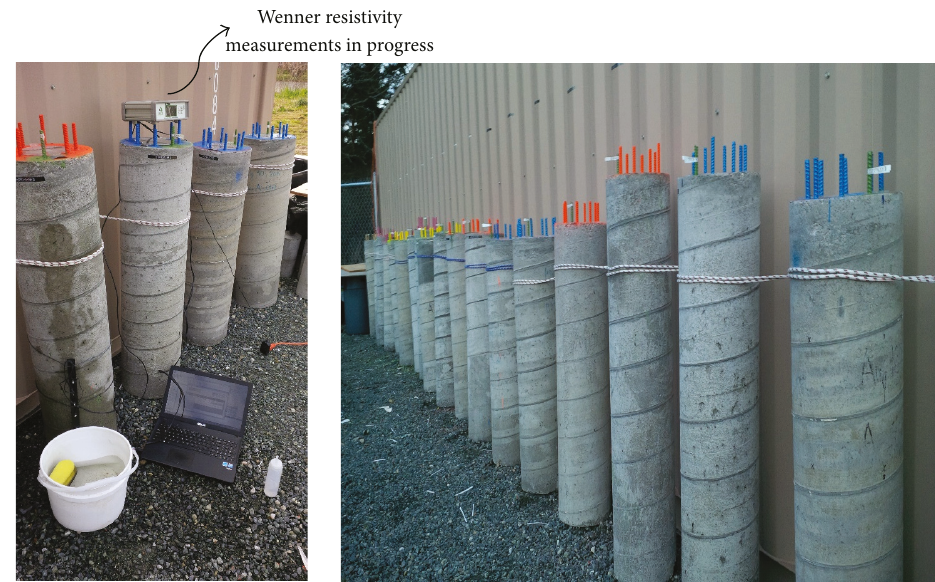
Figure 13: Instrumented circular hollow columns being studied by authors to establish the relationship between electrical resistivity and durability